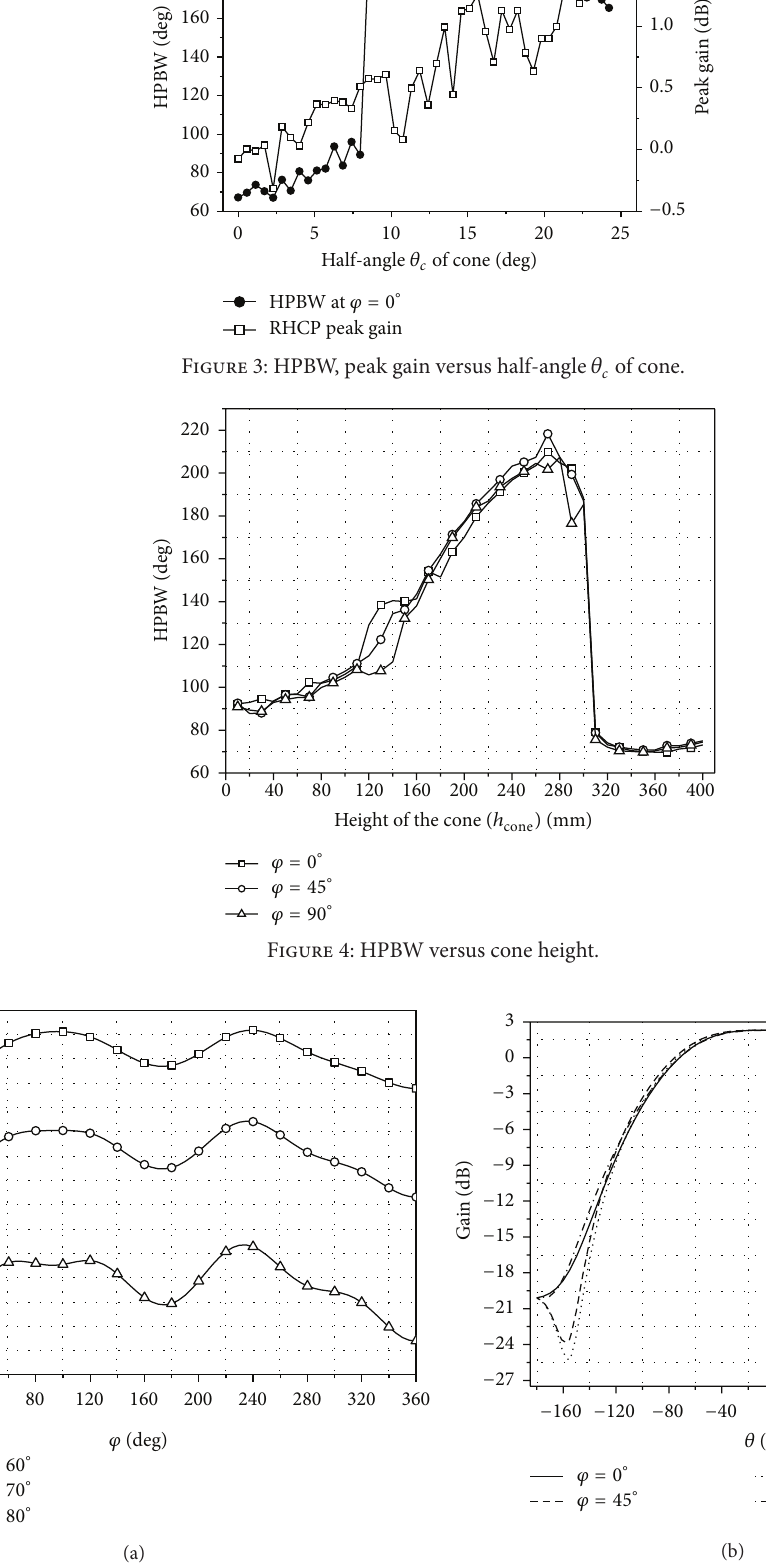
Figure 5: (a) Horizontal radiation pattern at low elevation angle; (b) radiation pattern for different 𝜑